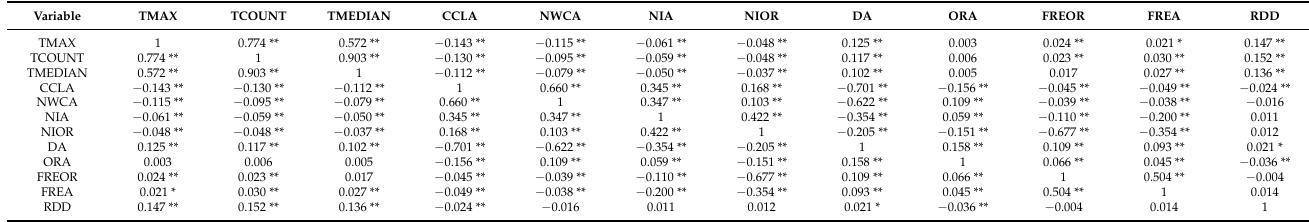
Table A3. Correlation